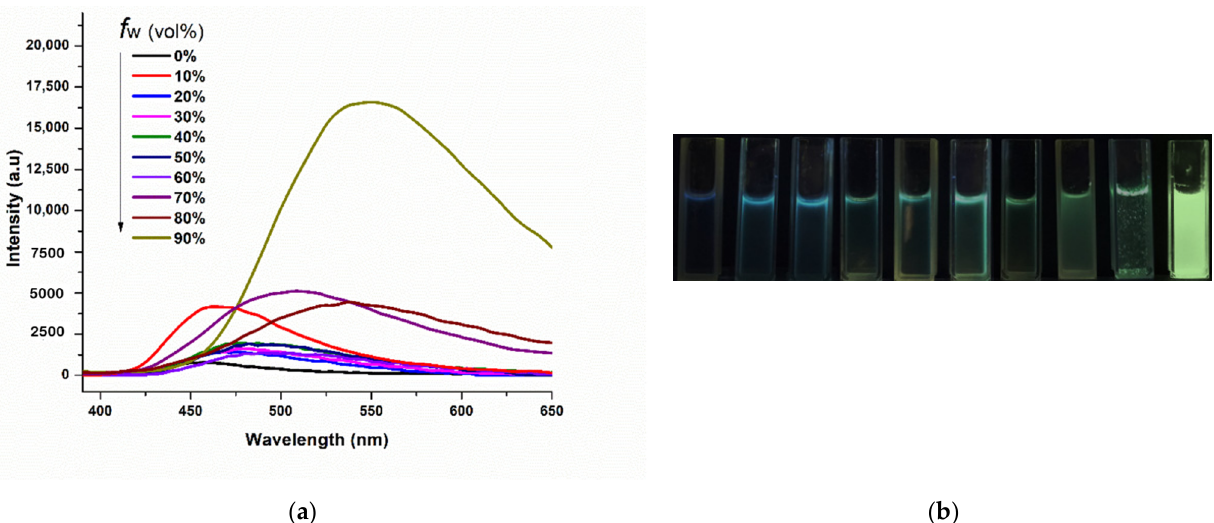
Figure 4. ( a ) The AIE spectra of 2e in THF/H 2 O mixture, with λ ex = 360 nm; ( b ) Photograph of 2e in THF/H 2 O mixture, under UV lamp ( λ ex = 365 nm).